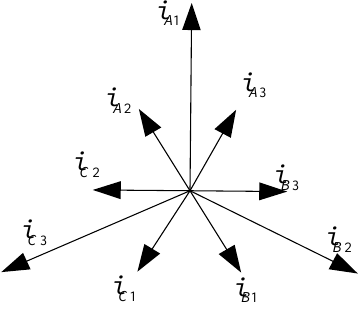
Figure 4. The AC currents phasor diagram of the LVC-VC.